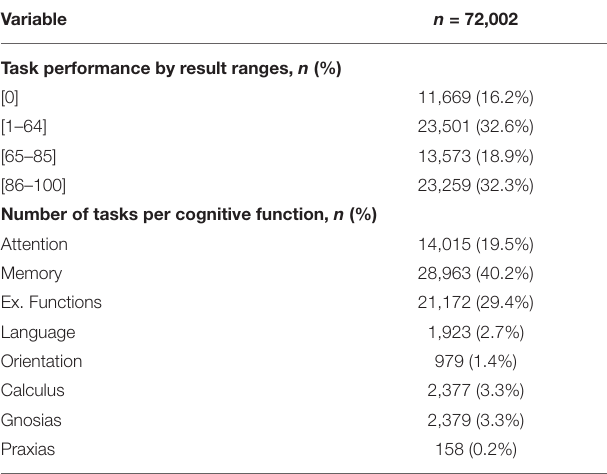
TABLE 4 | Summary report from temporal records of the GNPT